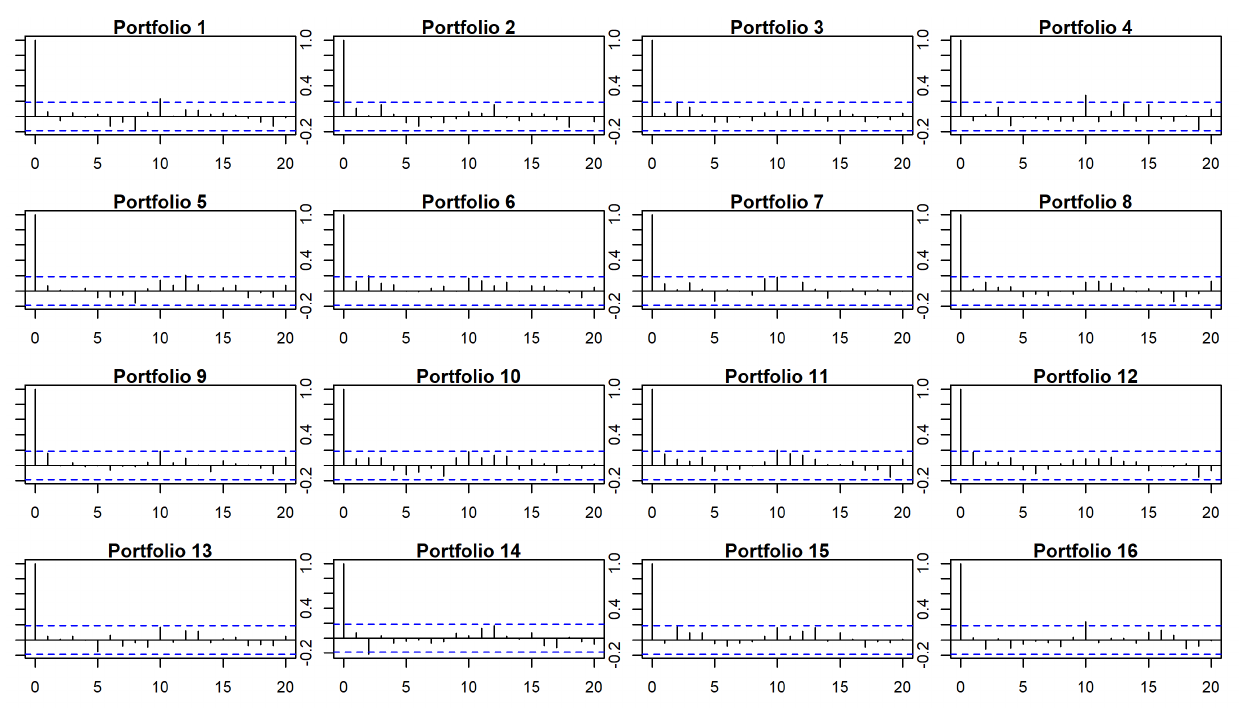
Figure 5. Autocorrelation charts for errors in TS regression for 5-factor model for the whole period. Table 10 contains the results for the inference based on resampling techniques. A graph- ical comparison is shown in Figure 6. The results of the basic bootstrap confidence in- tervals are consistent with what we have already commented. Despite having a lower GRS p -value than Model 1, we can conclude that this model is better as (1) resampling techniques show that we cannot reject that α s are jointly zero; (2) the average adjusted-